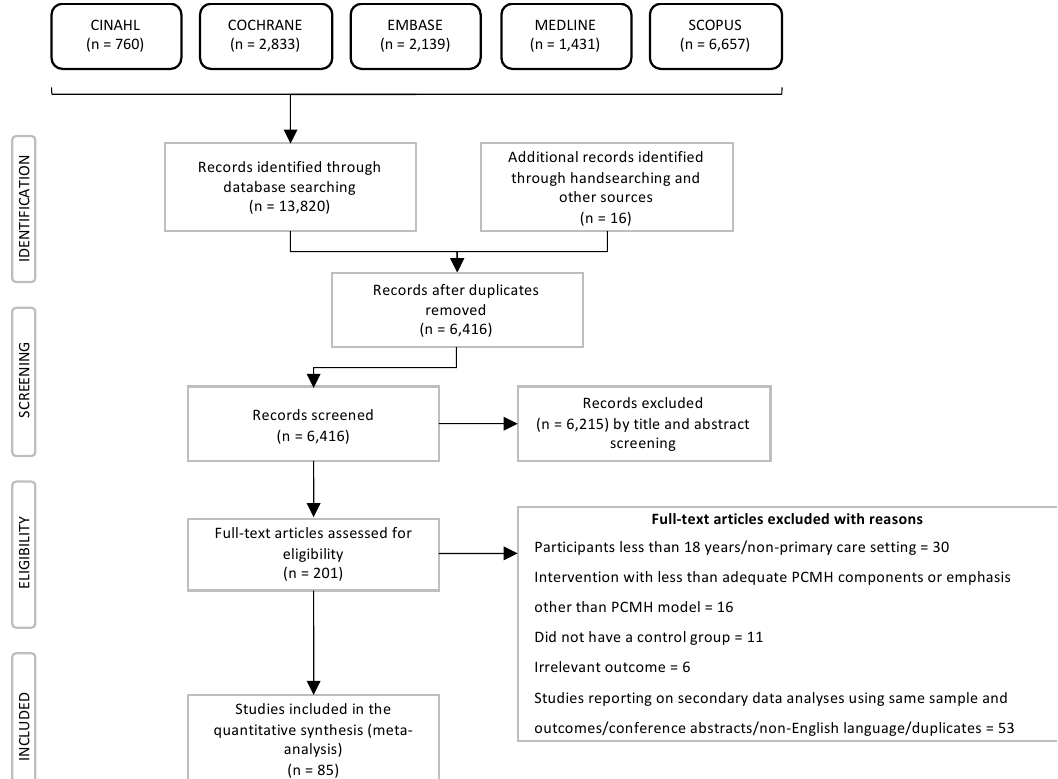
Figure 2. Preferred Reporting Items for Systematic Reviews and Meta-Analyses (PRISMA) Flowchart.